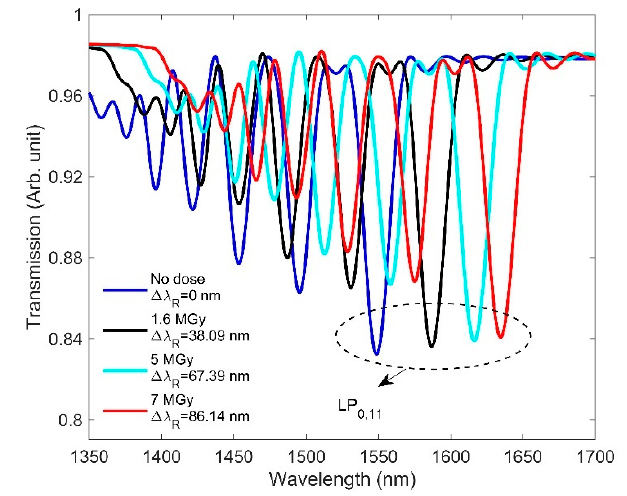
Figure 13. RIC effects on the transmission spectrum of the designed LPG at high doses.